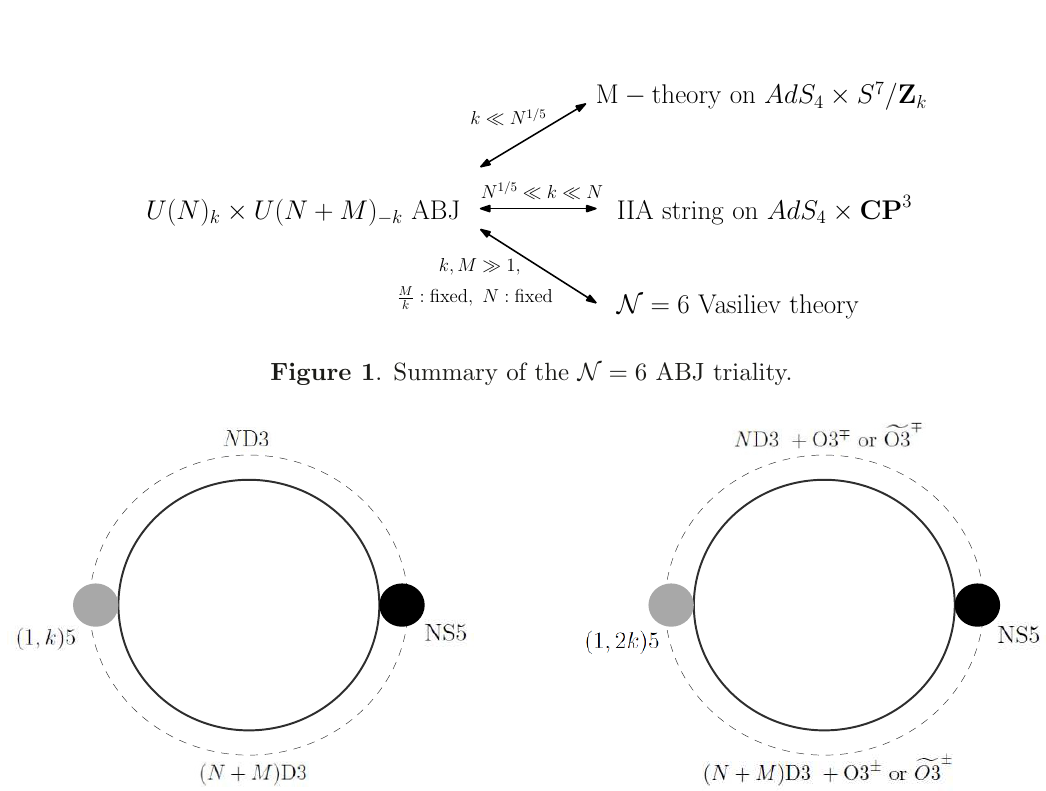
Figure 2 . The type IIB brane constructions for the ABJ theories. All the objects share three common dimensions and the D3-branes wind the S 1 -direction. [Left] The = 6 case with the gauge N group U( N ) k U( N + M ) − k . [Right] The = 5 case with the gauge group O ( N 1 ) 2 k USp(2 N 2 ) − k × N × where (rank[ O ( N 1 )] , N 2 ) = ( N, N + M ) or ( N + M, N